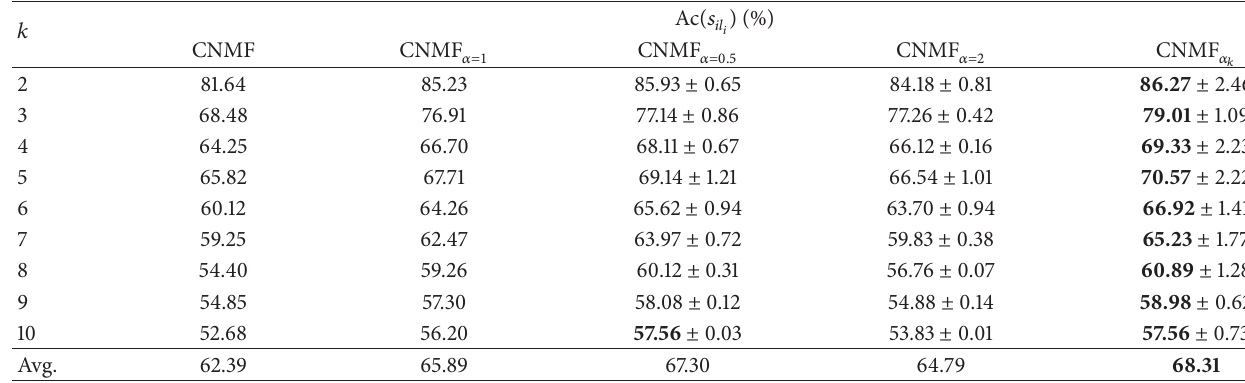
Table 3: The comparison of classification accuracy rates on the Yale Database.